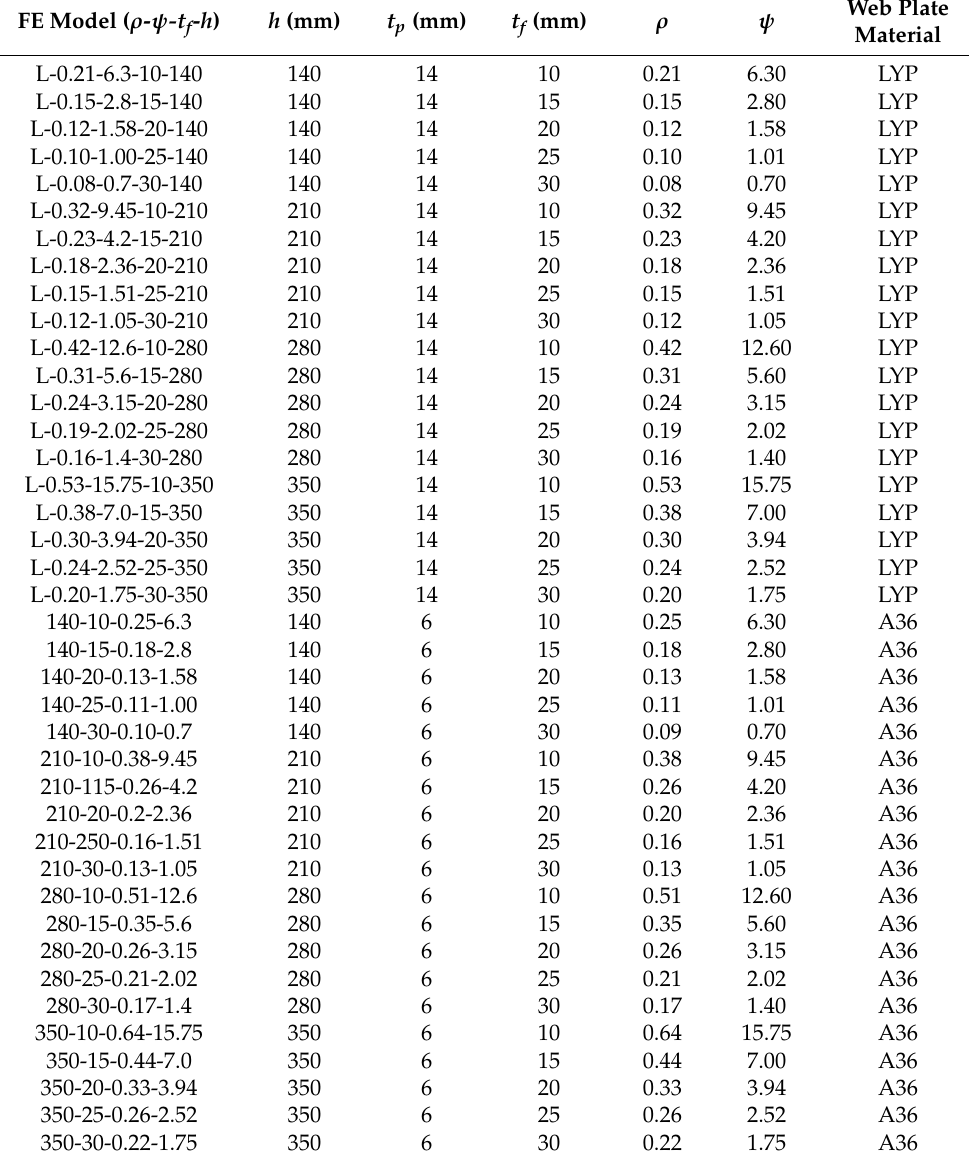
Table 2. Properties of the models for the parametric